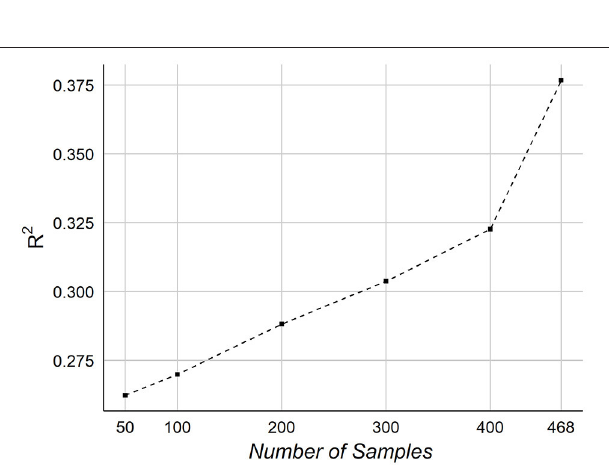
FIGURE 9 | Mean feature importance scores sorted by bands and channels for predicting Age. The darker the color, the more important is the feature.